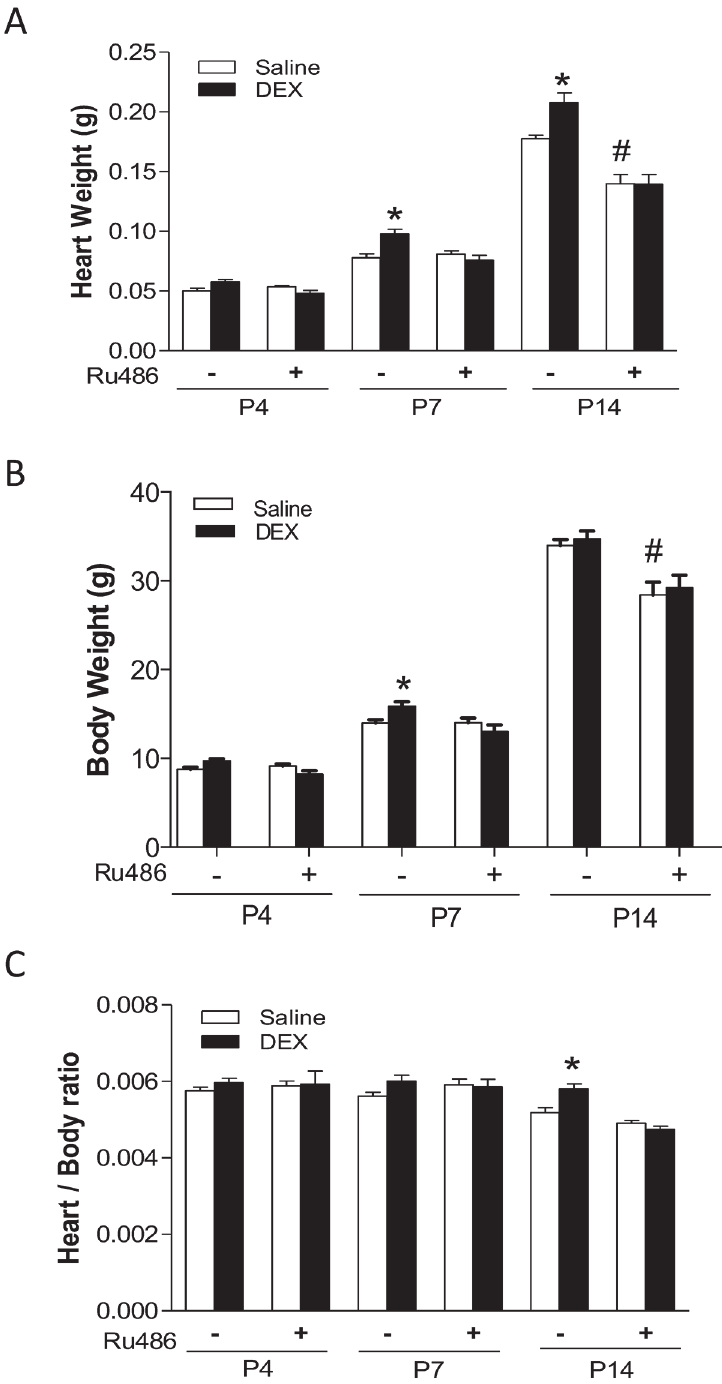
Fig 1. Effect of dexamethasone (DEX) on heart development in neonatal rats. Newborn rats were treated with tapered dose of DEX in the absence or presence of Ru486 during the first three days of postnatal life. Ru486 was administered 30 minutes prior to the DEX treatment. Heart and body weights were determined in day 4 (P4), day 7 (P7) and day 14 (P14) neonatal rats. Data are mean ± SEM, n = 10 – 21. * p < 0.05, DEX vs . Saline; # p < 0.05, +Ru486 vs